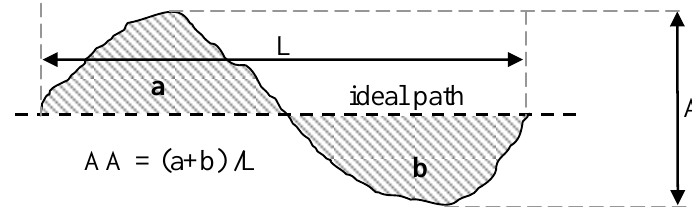
Figure 6. Graphic definition of the A and AA parameters.